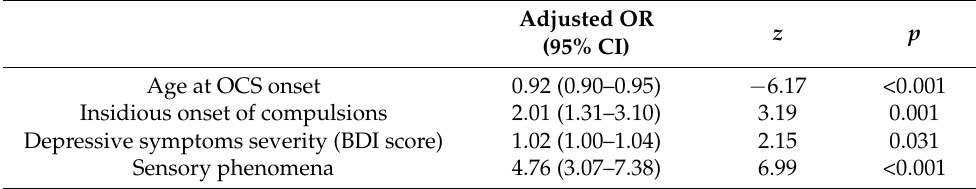
Table 4. Variables that remained associated with the symmetry dimension in the logistic